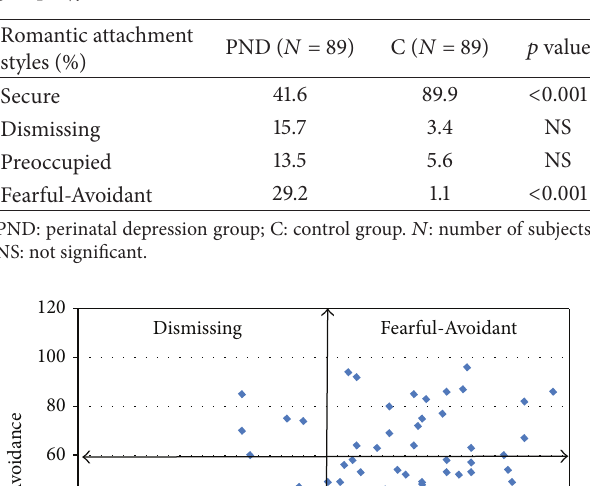
Table 3: Comparison of romantic attachment styles in the two groups ( 𝜒 2 ).